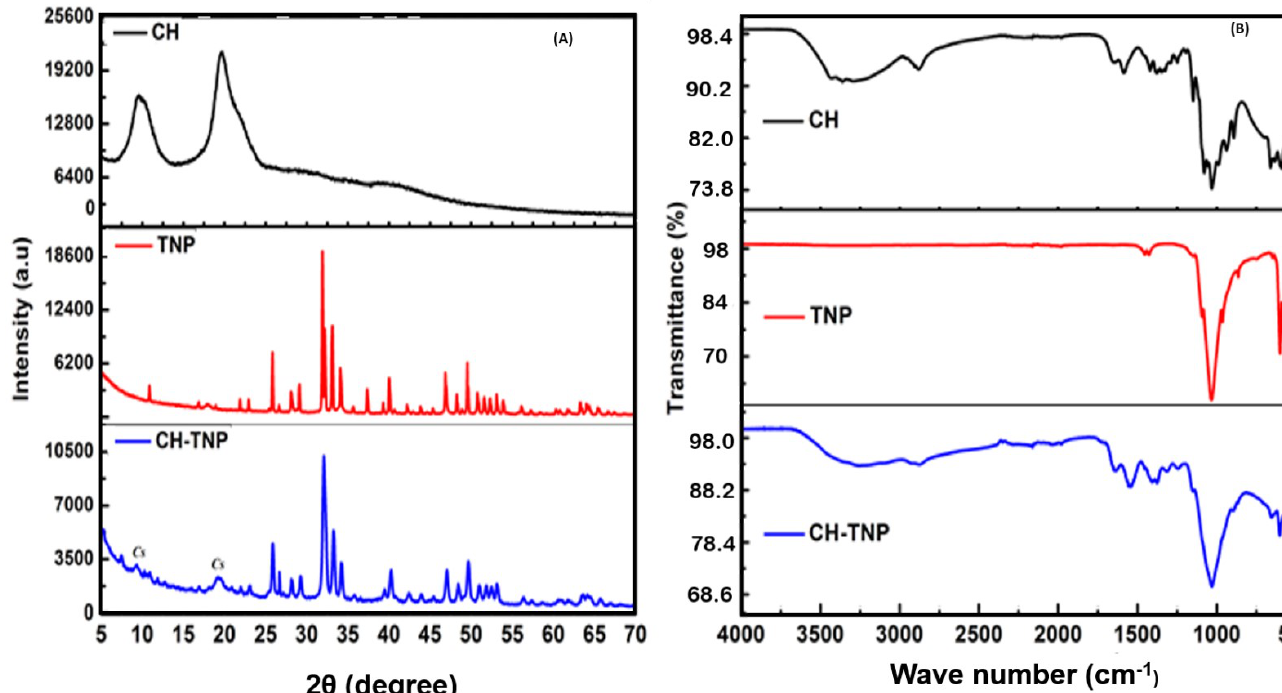
Figure 1. XRD patterns ( A ) and FT-IR spectra ( B ) of samples.